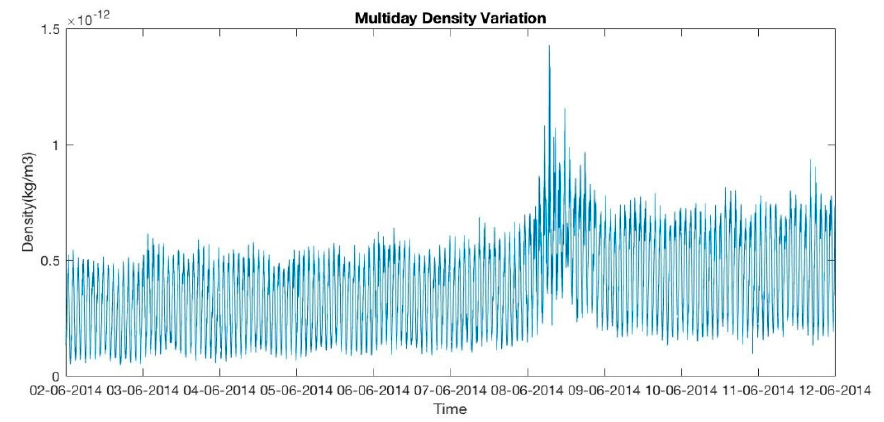
Figure 2. Same as Figure 1 but for multi – day variation.